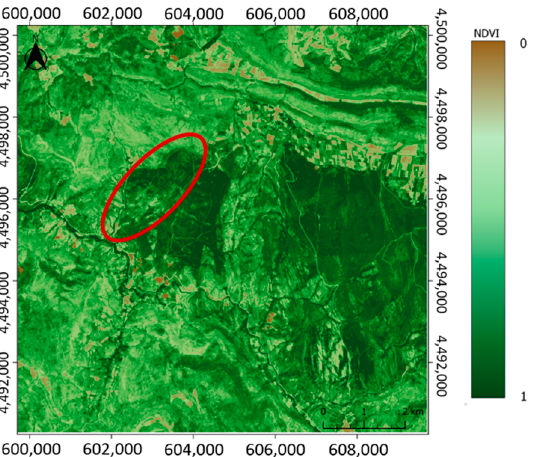
Figure 3. NDVI distribution in Chequilla, Spain. 23 June 2012. The study area is delineated by a red